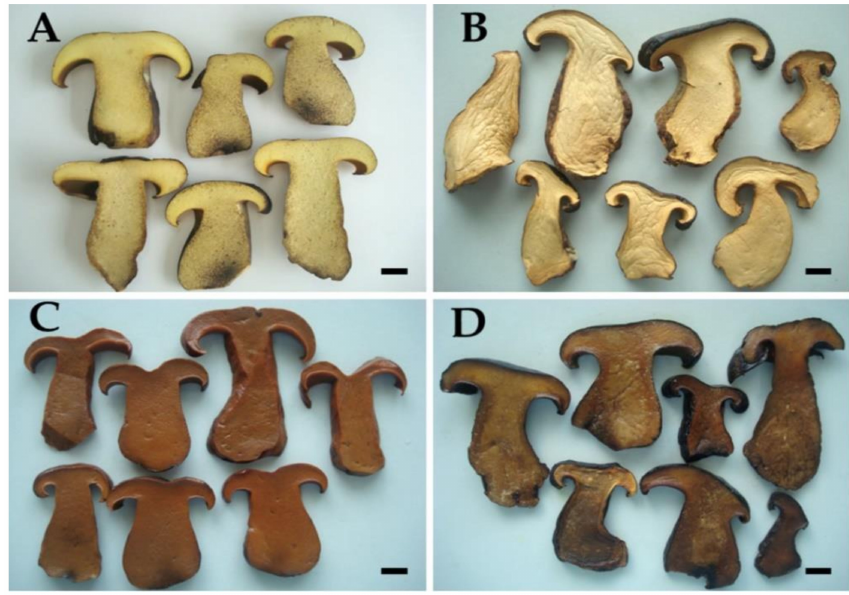
Figure 2. Fresh and one-year storage of tropical black bolete mushroom samples. ( A ) Fresh samples. ( B ) Dried samples. ( C ) Brined samples. ( D ) Frozen samples. Scale bar = 1